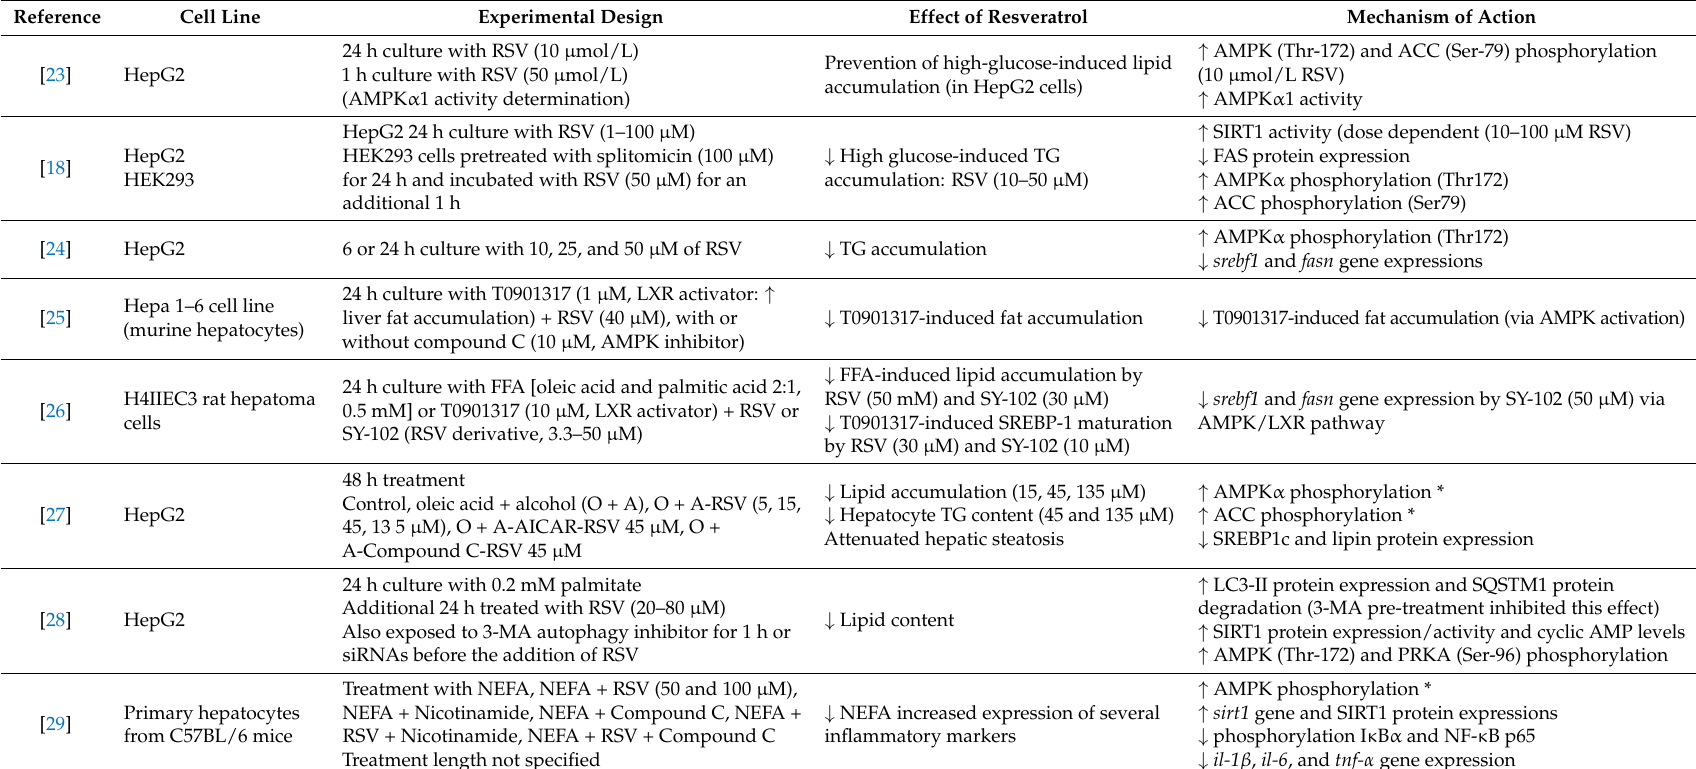
Table 1. In vitro studies conducted to test the effect of resveratrol in liver